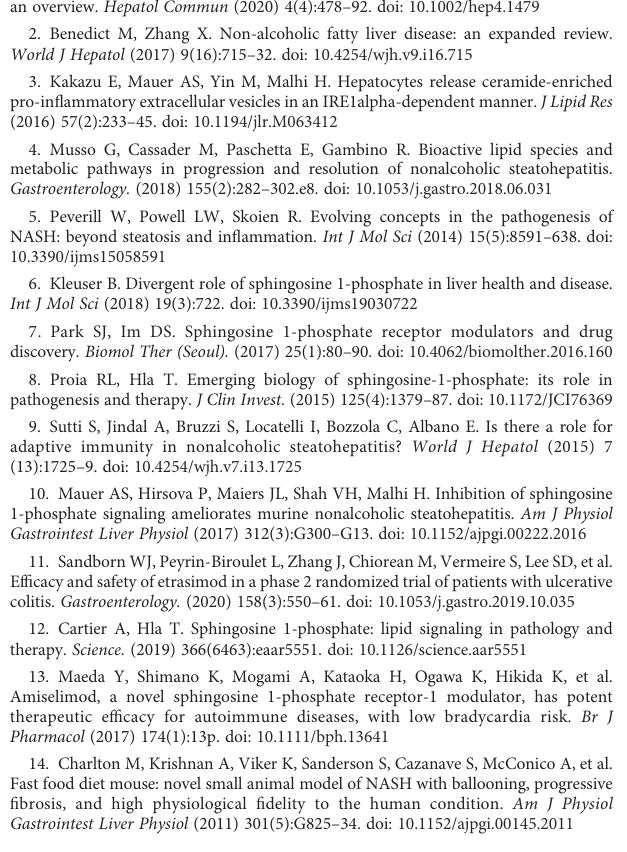
factor alpha ( Tnfa) and Interleukin 1 beta ( Il1b) in liver tissues of CD and FFC- fed mice treated with vehicle or Amiselimod. (I-K) Relative mRNA expression of Timd4, Marco and Trem2 positive macrophages in CD and FFC cohorts treated with vehicle or Amiselimod. CD (vehicle n=5, Amiselimod n=5) and SUPPLEMENTARY FIGURE 6 FFCdiet-induced increasein hepatocyte proliferation is reducedin Etrasimod and Amiselimod treated mice. (A) Representative images showing immunohistochemistry for Ki67 in liver tissue sections for vehicle and Etrasimod treated mice in both CD and FFC cohorts. (B) Positive immunoreactive staining (dark brown) was quanti fi ed as Ki67 positive nuclei per high power fi eld in CD and FFC-fed mice treated with vehicle or Etrasimod. CD (vehicle n=4, Amiselimod n=6) and FFC (vehicle n= 5, Amiselimod n=6). (C) Representative images showing immunohistochemistry for Ki67 in liver tissue sections for vehicle and Amiselimod treated mice in both CD and FFC cohorts. (D) Positive immunoreactive staining (dark brown) was quanti fi ed as Ki67 positive nuclei per high power fi eld in CD and FFC-fed mice treated with vehicle or Amiselimod. Scale bars represent 50 m m. CD (vehicle n=4, Amiselimod SUPPLEMENTARY FIGURE 7 Hepatocyte differentiation is comparable in vehicle treated and Etrasimod or AmiselimodtreatedFFC-fedmouselivers. (A) Representativeimagesshowing immunohistochemistry for HNF4 a in liver tissue sections for vehicle and Etrasimod treated mice in both CD and FFC cohorts. (B) Representative images showing immunohistochemistry for HNF4 a in liver tissue sections for vehicle and Amiselimod treated mice in both CD and FFC cohorts. Scale bars represent 50 m